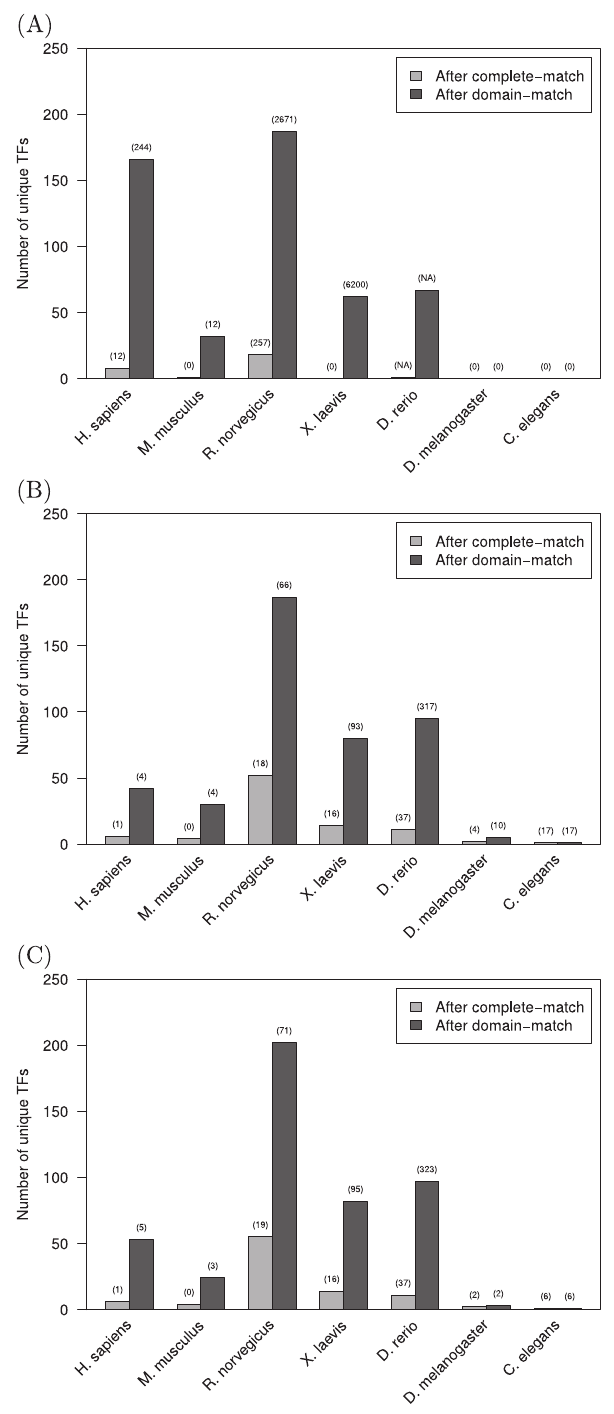
Figure 3. The number of unique transcription factors with position weight matrices (PWMs) resulting from domain-level homology mappings that did not previously have any associated PWMs. The number of unique factors resulting from mapping between completely-identical sequences is compared to the number of factors resulting from identical DNA binding domain-level mapping for the (A) JASPAR, (B) TRANSFAC, and (C) JASPAR & TRANSFAC databases. The number in parenthesis above each bar is the percentage increase above the initial annotated total number of unique transcription factors with PWMs. Significantly increased species- associated transcription factor coverage is enabled by domain-level